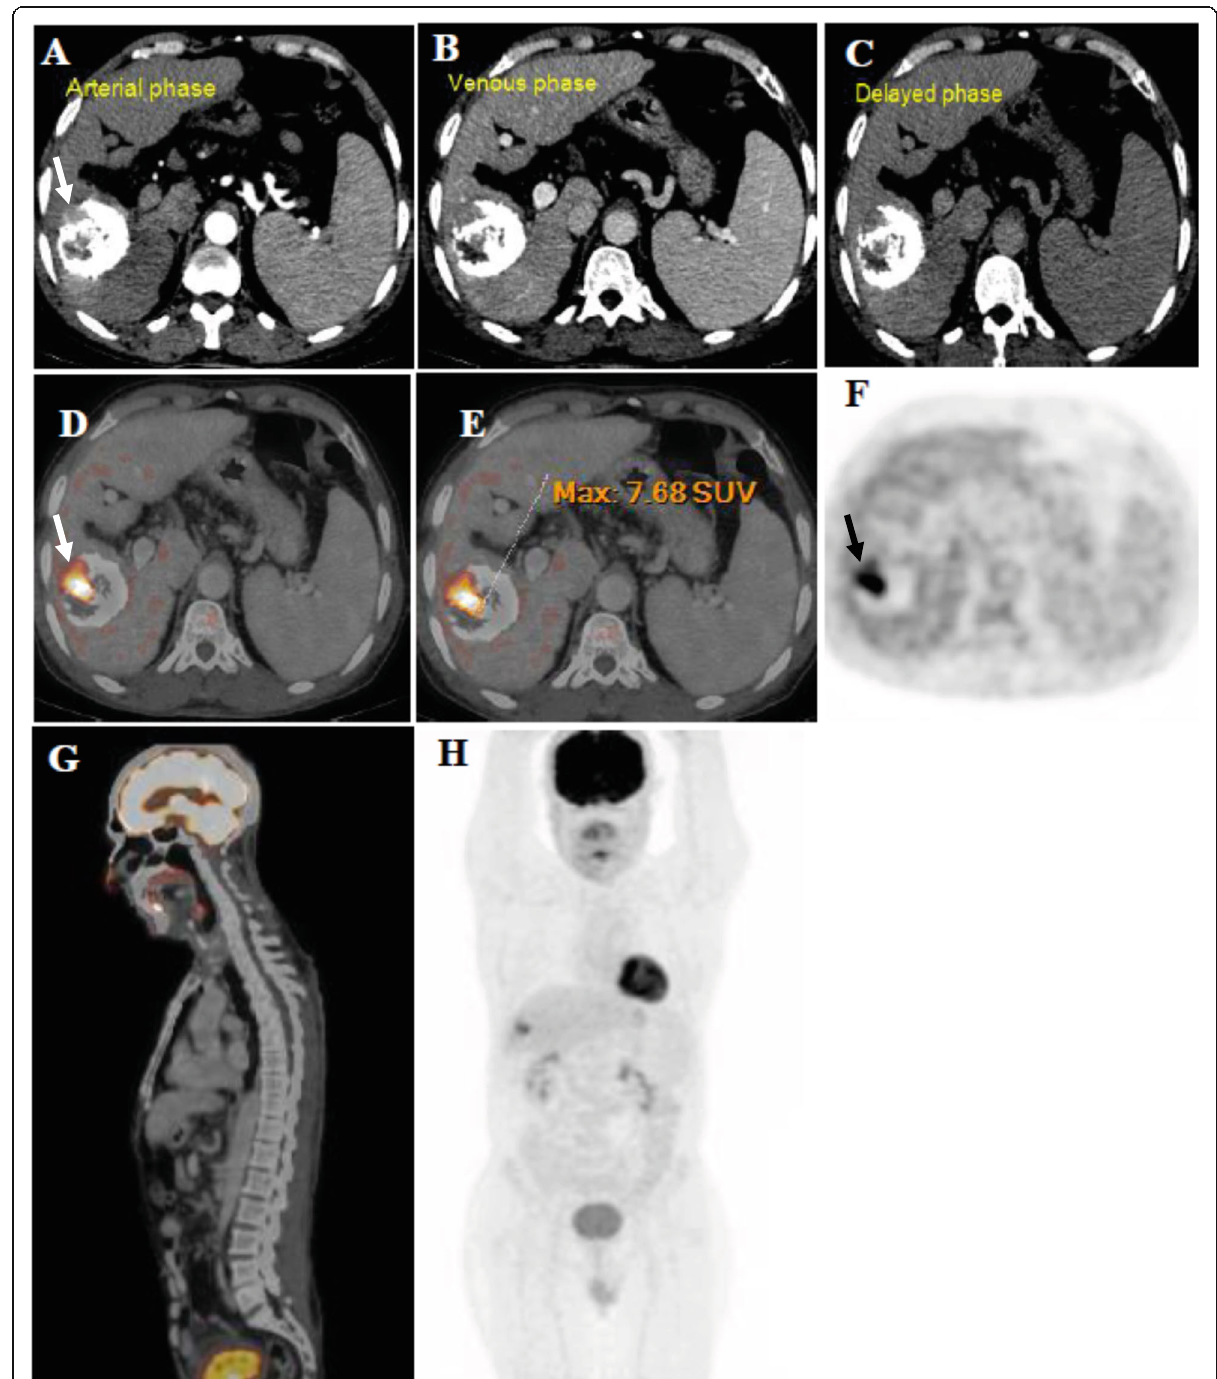
Fig. 1 a – c CECT phases revealed localized lipiodol concentration at the right hepatic lobe chemoembolized lesion with residual area at the anterior part of the lesion with defective lipiodol and mild contrast enhancement(arrow). d and e Fused PET/CT image showing hyper metabolic activity at the suspected superior margin of the chemoembolized lesion(arrow). f Axial computed tomography-based attenuation correction image (CTAC) image showing focal FDG uptake(arrow). g S agittal fused PET/CT whole spine shows no vertebral osseous deposits. h 3D CTAC summarizing the whole